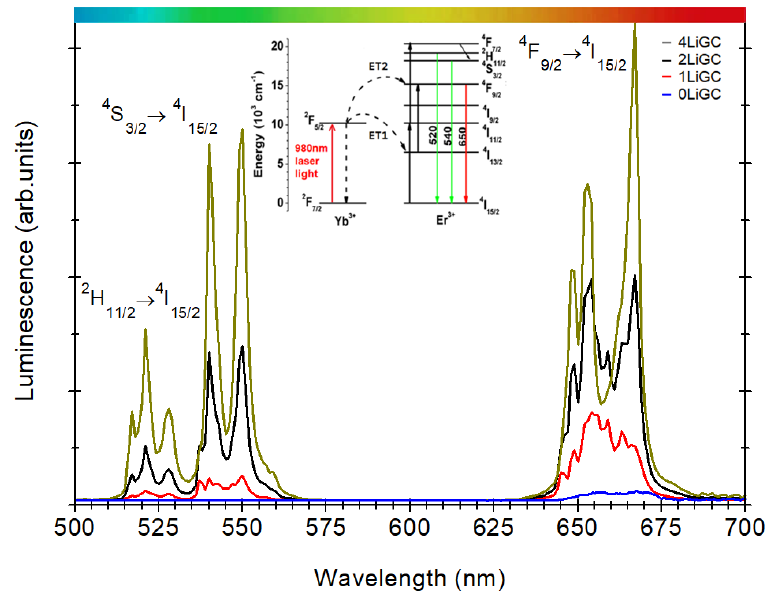
Figure 5. Up-conversion luminescence spectra recorded on Yb 3+ /Er 3+ -doped SiO 2 -GdF 3 /LiGdF 4 nano- glass ceramic with different Li-ions doping levels under 980 nm laser light pumping. The energy levels diagram of the Yb 3+ and Er 3+ ions and the main processes are shown in the inset.